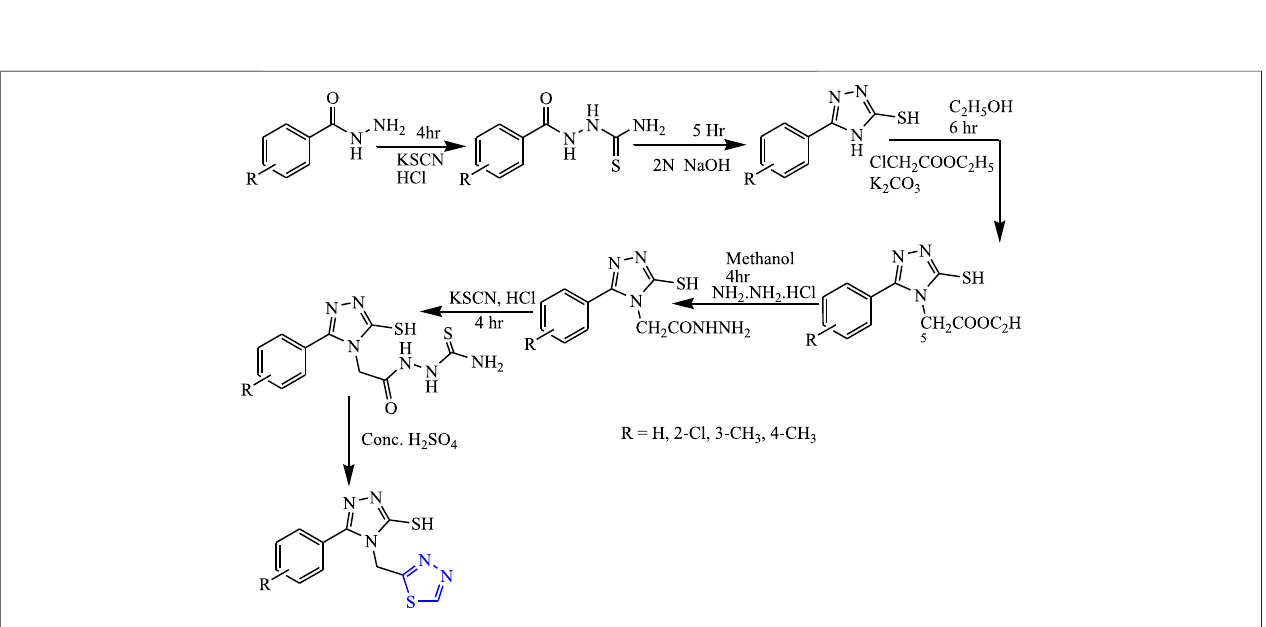
FIGURE 13 | Systematic scheme for synthesizing compounds by substituting 1,3,4-thiadiazole with Phenyl hydrazides and Benzoic acid.